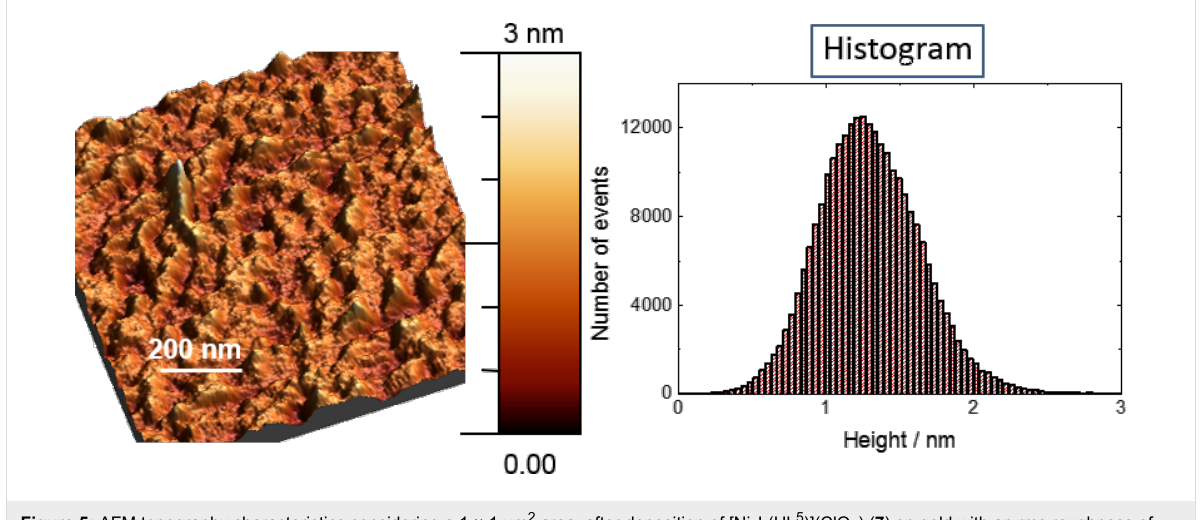
Figure 5: AFM topography characteristics considering a 1 × 1 μ m 2 area, after deposition of [Ni 2 L(HL 5 )](ClO 4 ) ( 7 ) on gold with an rms roughness of 13 Å.